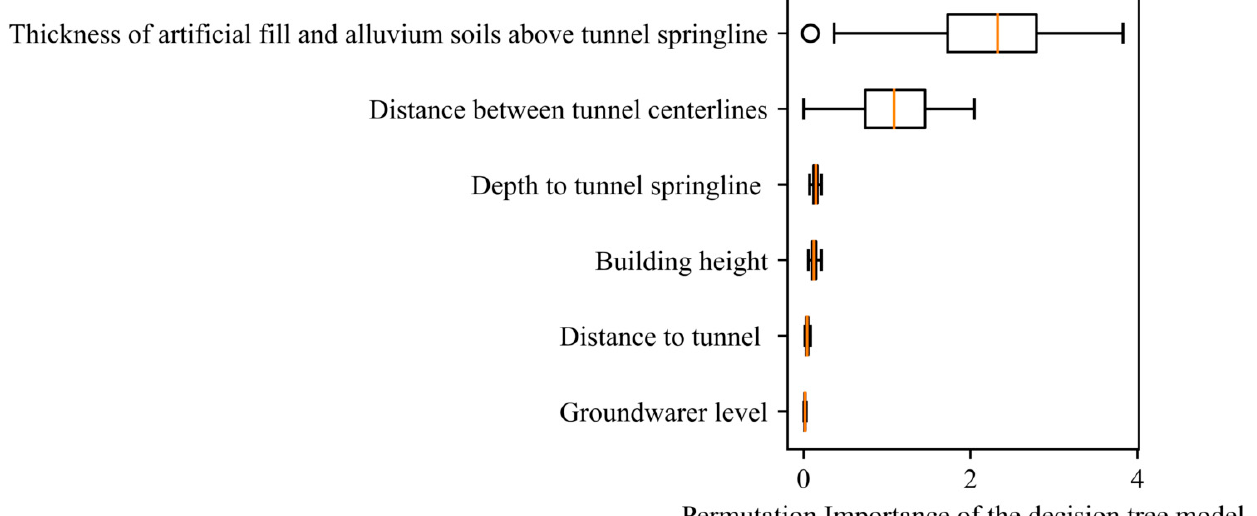
Figure 9. Average LOS settlement map before tunneling. ( a ) shows a high density of measurement points over the study area. ( b ) is the contour derived from ( a ). Two yellow dashed squares in ( b ) indicate concentrated settlement locations mapped in Figure 8 correspondingly.